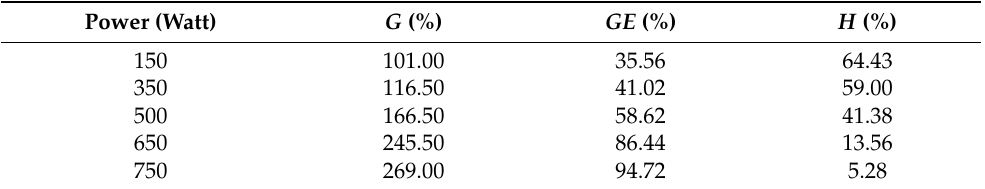
Effect of irradiation power on grafting parameters (t = 100 s.; mxan = 0.2 g/L; mAAm = 8.0